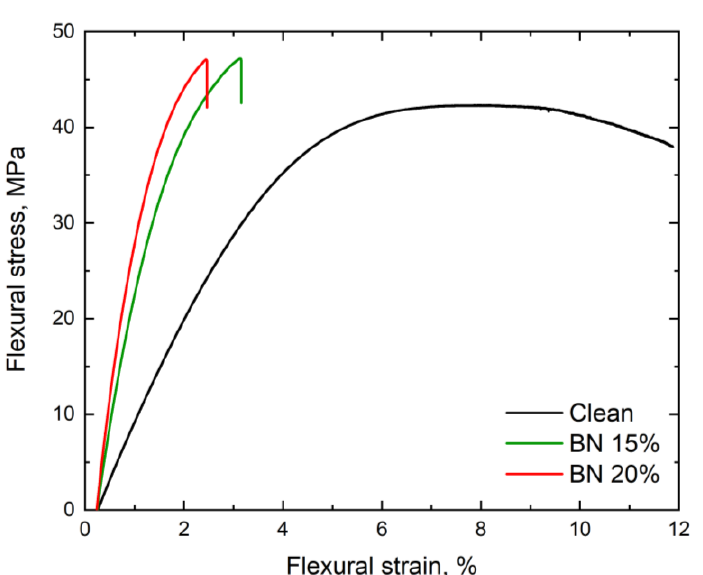
Figure 3. TGA analysis of the samples.